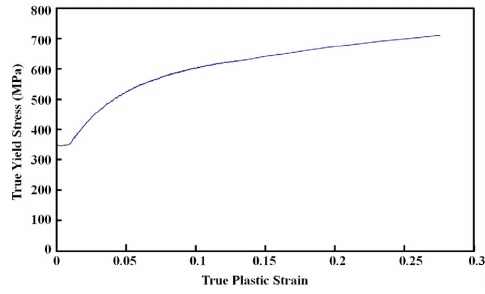
Figure 1. Hardening curve of the matrix